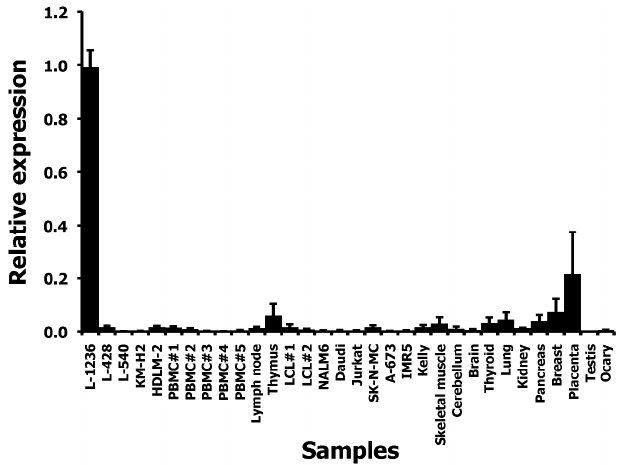
Figure 2. Quantification of THOLE transcripts in HL cell lines and other samples. cDNA from HL cell lines, PBMC, and a panel of normal tissues and tumor cell lines was used as template for quantitative RT-PCR. Expression in L-1236 cells was set as one. Presented are means and standard deviations from three experiments. The phenotype of cells essentially depends on the spectrum of genes that are expressed in these cells. In addition to conventional genes, genomes of all animals contain several families of repetitive